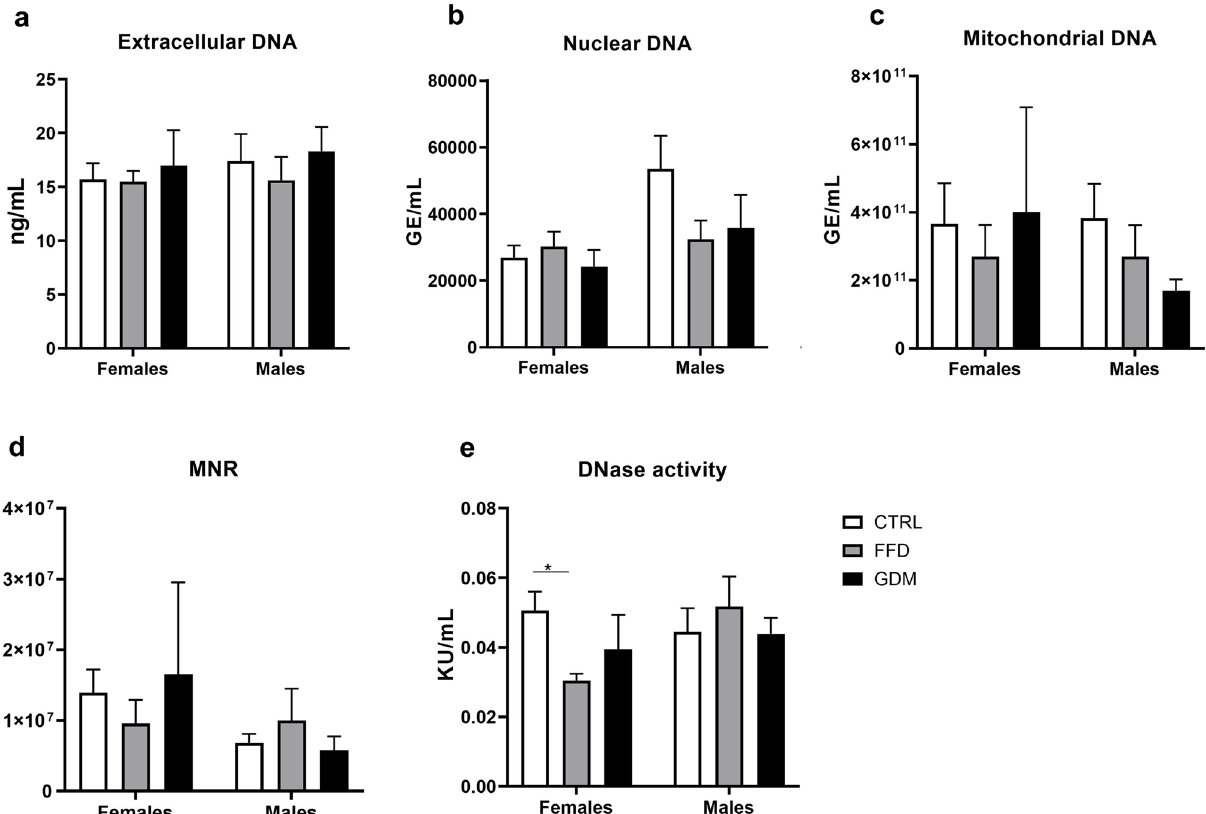
Figure 4. Data from the offspring. ( a ) Plasma extracellular deoxyribonucleic acid concentrations: p group = 0.631, p sex = 0.537, p group*sex interaction = 0.916; ( b ) numbers of nuclear genomic equivalents (GE) in plasma: p group = 0.302, p sex = 0.033, p group*sex interaction = 0.215; ( c ) numbers of mitochondrial genomic equivalents (GE) in plasma: p group = 0.625, p sex = 0.486, p group*sex interaction = 0.576; ( d ) ratio of mitochondrial-to-nuclear (MNR) genomic equivalents: p group = 0.957, p sex = 0.104, p group*sex interaction = 0.449; ( e ) deoxyribonuclease (DNase) activity in plasma: p group = 0.438, p sex = 0.187, p group*sex interaction = 0.048; KU Kunitz units; groups: CTRL offspring of dams consuming control diet, FFD offspring of dams administered fast-food diet (cheeseburgers), GDM offspring of dams with gestational diabetes mellitus; *p <